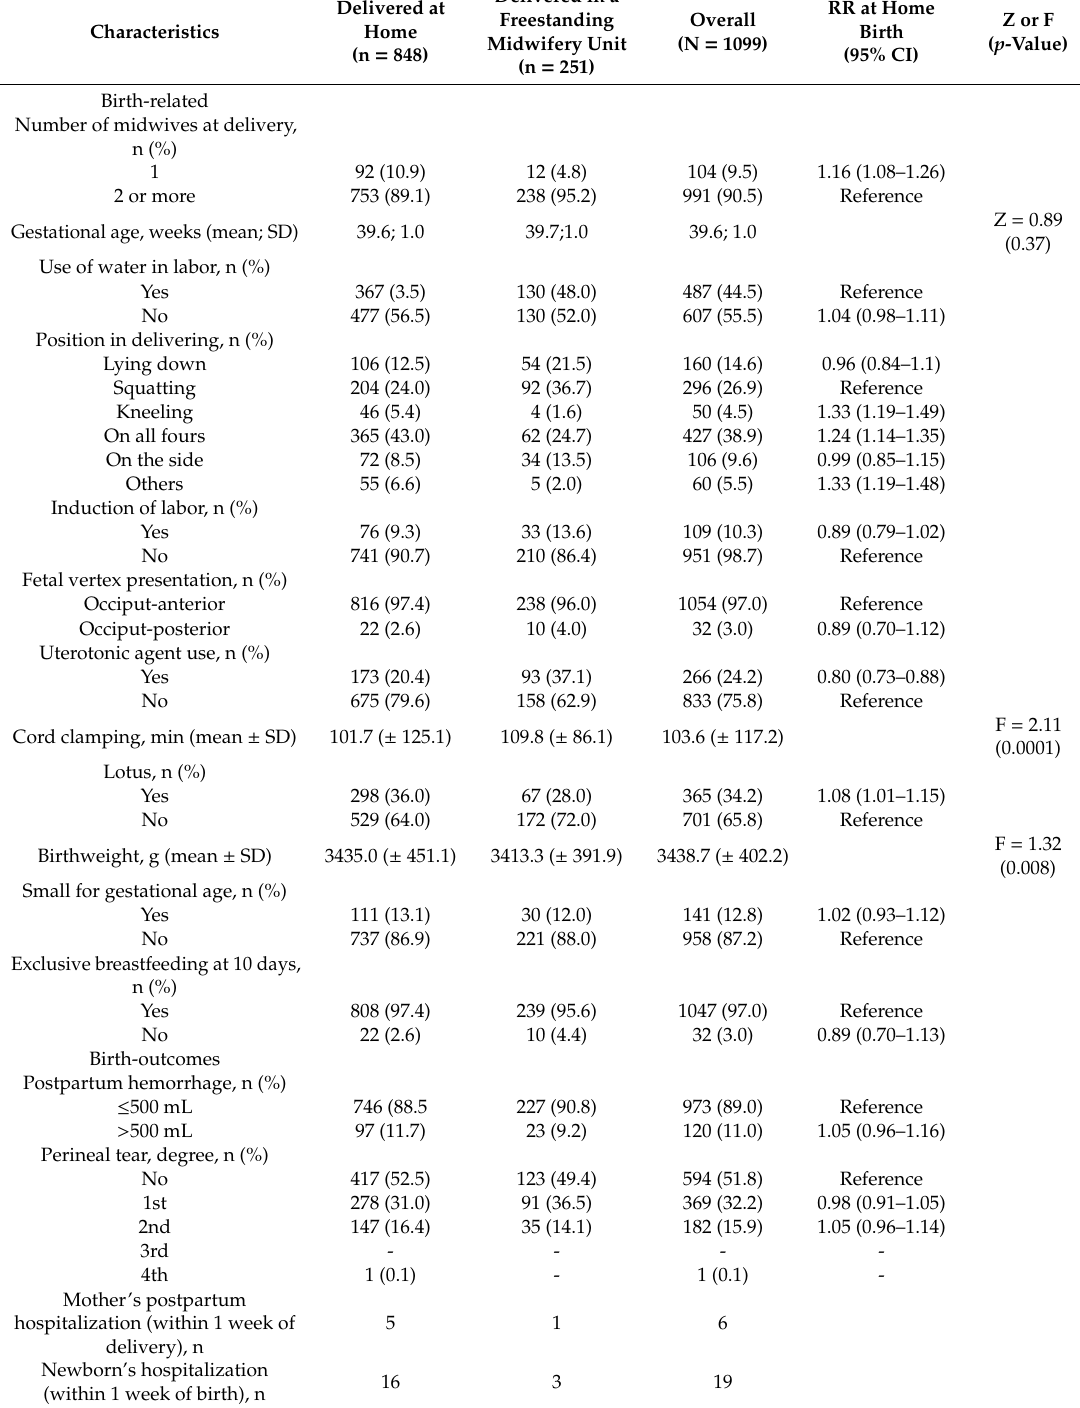
Table 3. Birth-related characteristics by birth at home or in a midwifery